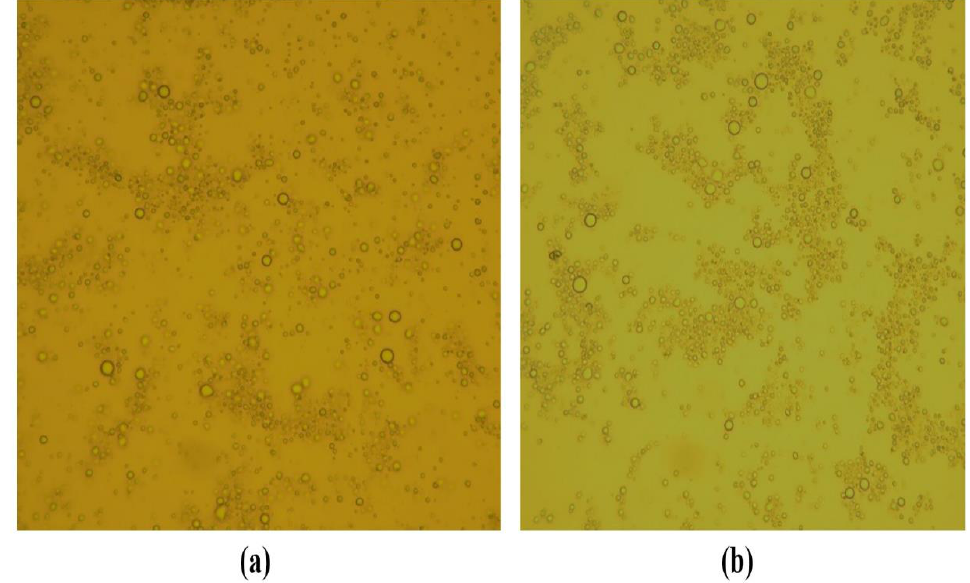
Figure 4. Morphological analysis of ( a ) the moisturizing cream (F4) and ( b ) the lotion (F5) under a polarized microscope.